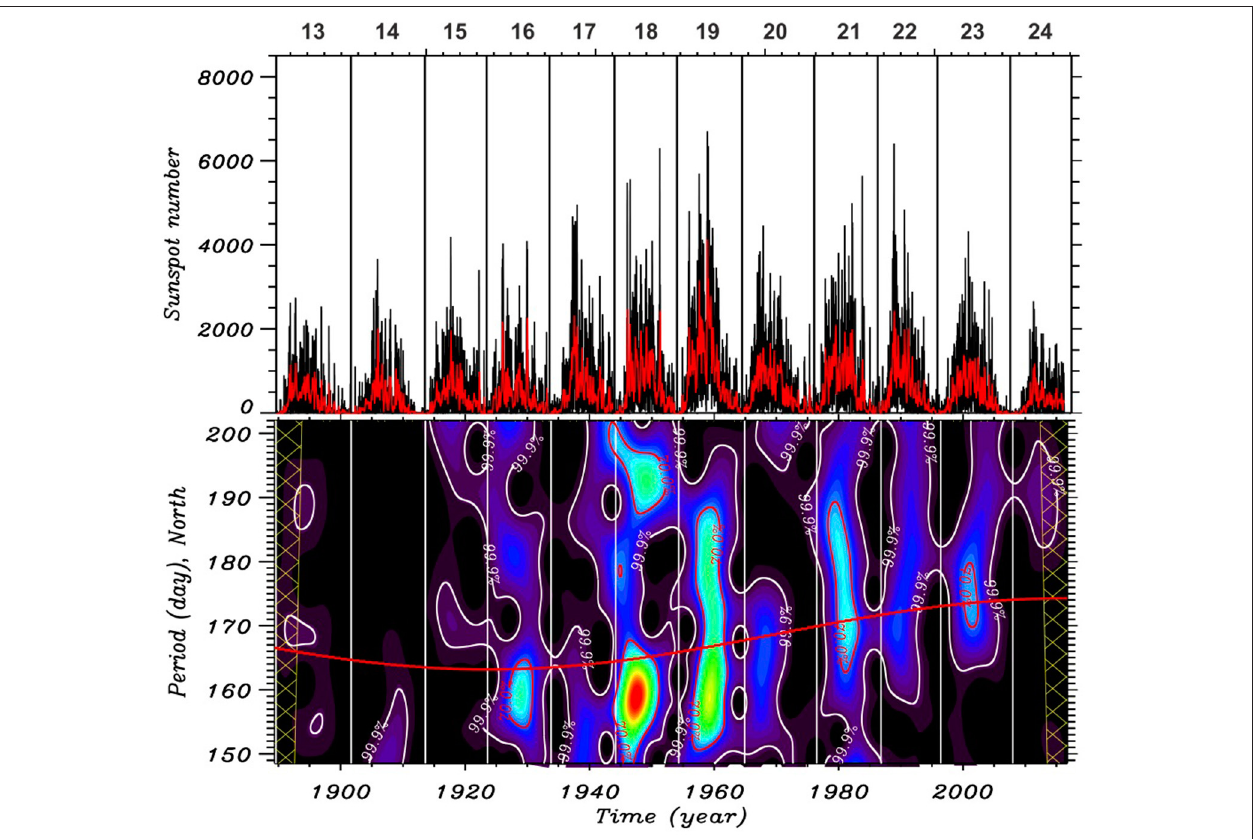
FIGURE 1 | The upper panel represents GRO daily (black) and monthly averaged (red) hemispheric sunspot area data for cycles 13–24 for the northern hemisphere. The lower panel shows the corresponding wavelet